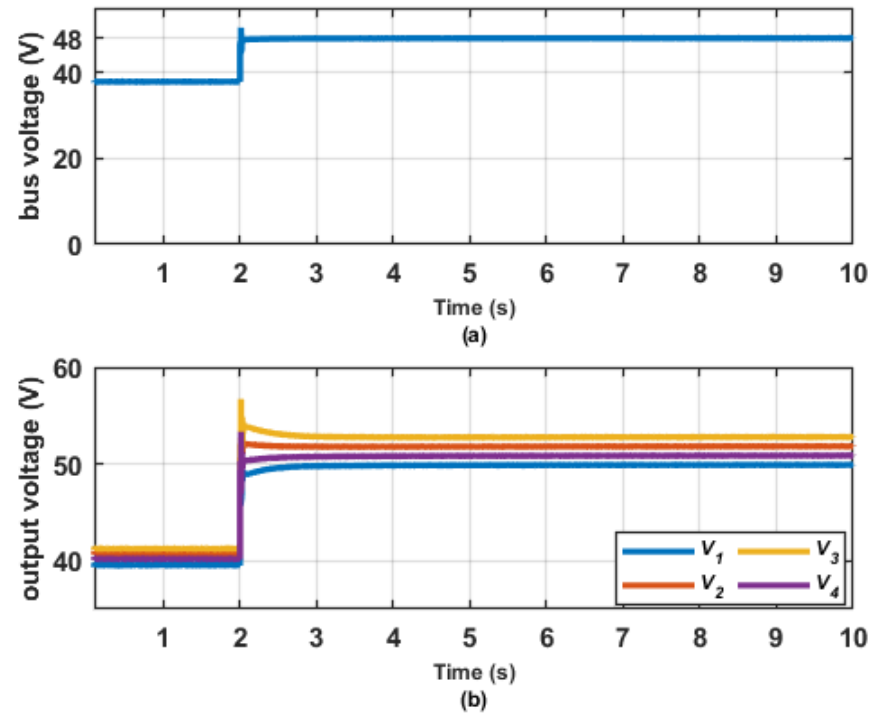
Figure 6. ( a ) DC bus voltage; ( b ) output voltage of DGs using Topology